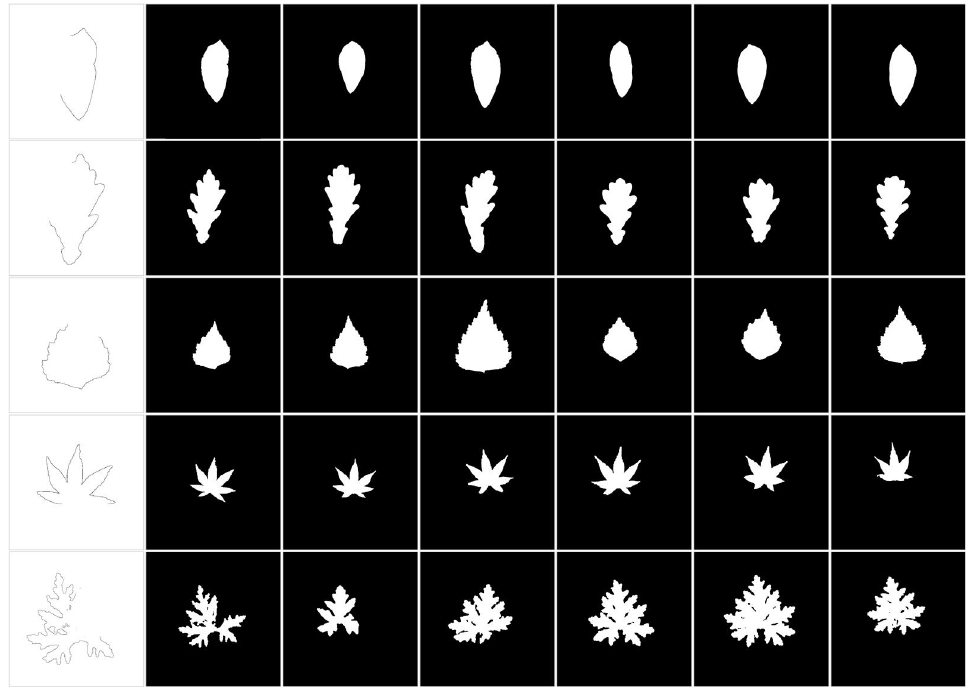
Figure 11. The left-most column shows a schematic diagram of the object shape contour artificially occluded (in order to verify the effectiveness of the proposed method in the shape recognition stage), and the rest are the five types of shapes in the Plant Leaf 270.